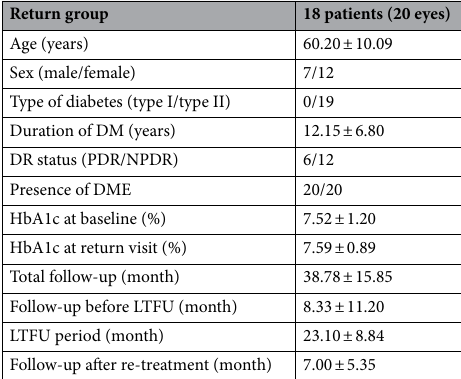
Return group 18 patients (20